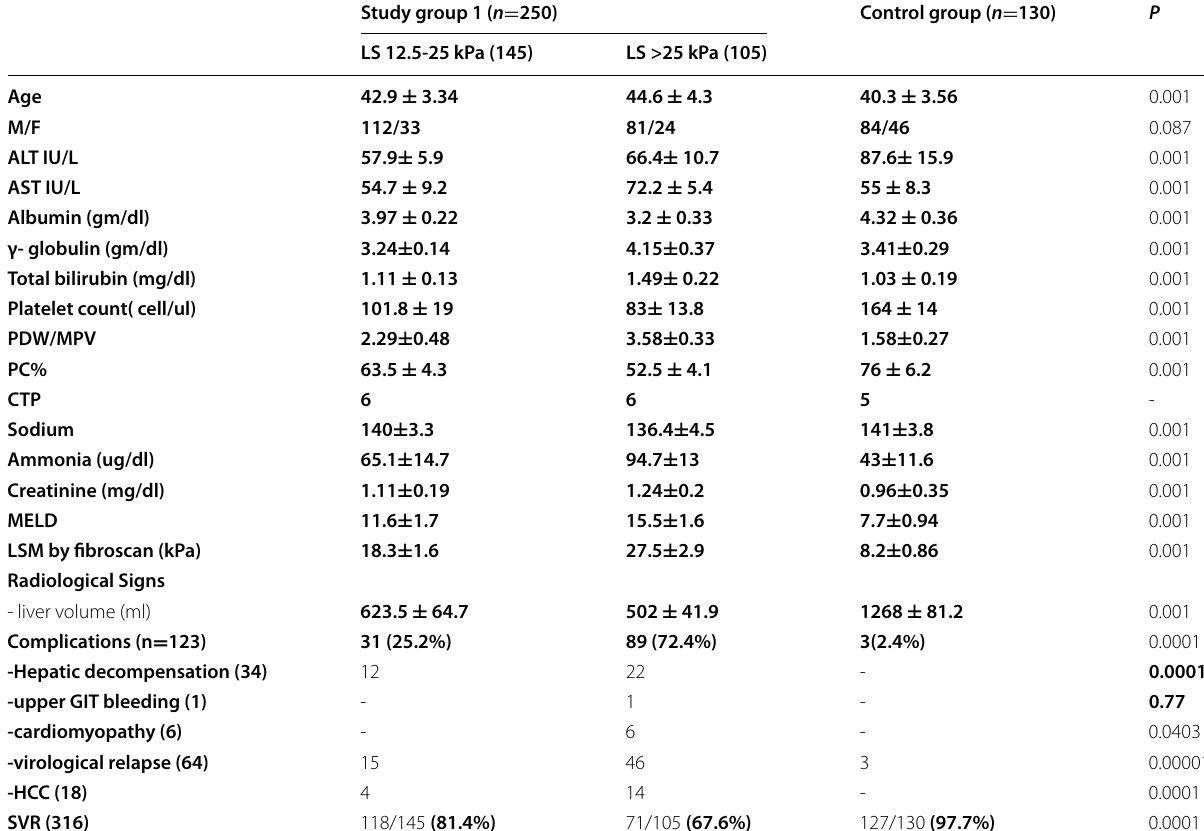
Table 2 Comparison of demographic, laboratory, and radiological characteristics in the group 1 based on liver stiffness, with comparison to the control group treated with